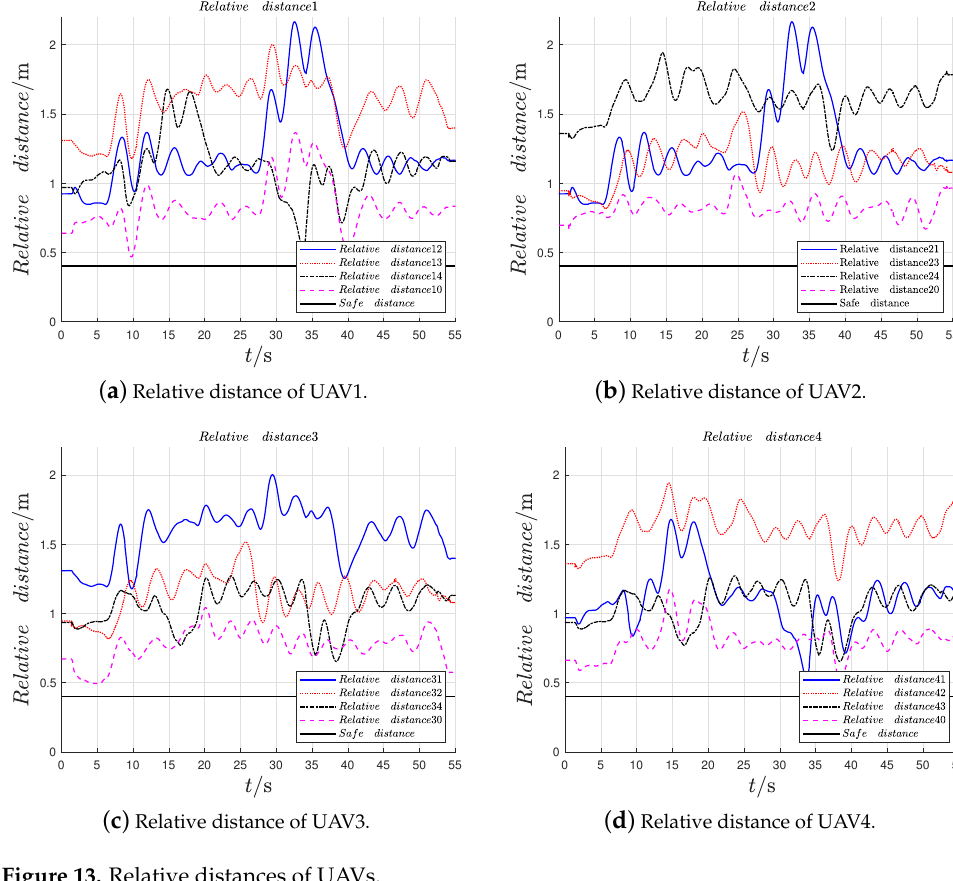
Figure 13. Relative distances of UAVs.